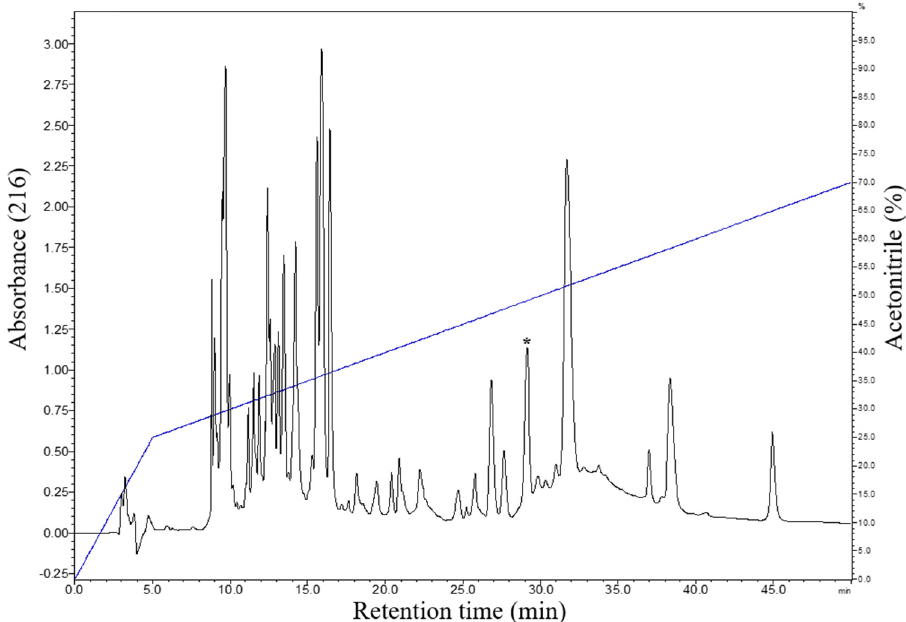
Figure 2. Typical chromatographic profile of the fractionation of the crude secretion of B. raniceps , using a C 18 column (Shim-pack VP-ODS, no. 2122095, 4.6 mm × 150 mm, 5 µm) with a flow rate of 1 mL/min and detection at 216 nm. The fraction with antimicrobial activity that was characterized in the present study is indicated by an asterisk.